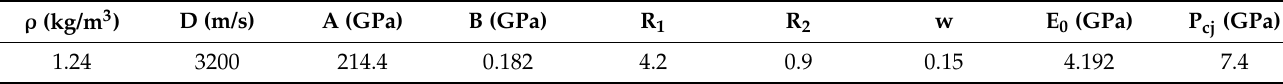
Table 1. Explosives parameters.